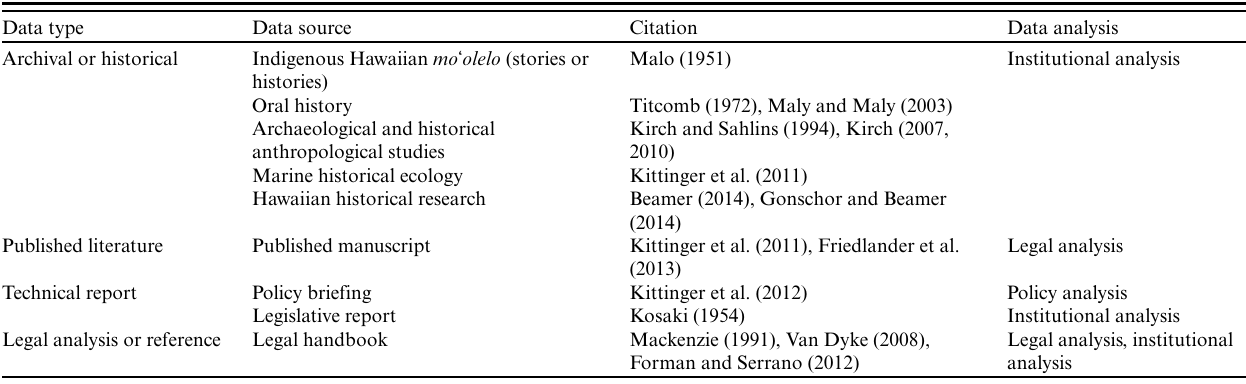
Table 1. Data types, sources, citations, examples, and analytical tools used to examine changes in property rights and administrative decision making over three time periods and governance regimes in Hawai ʻ i coral reef fisheries. N =